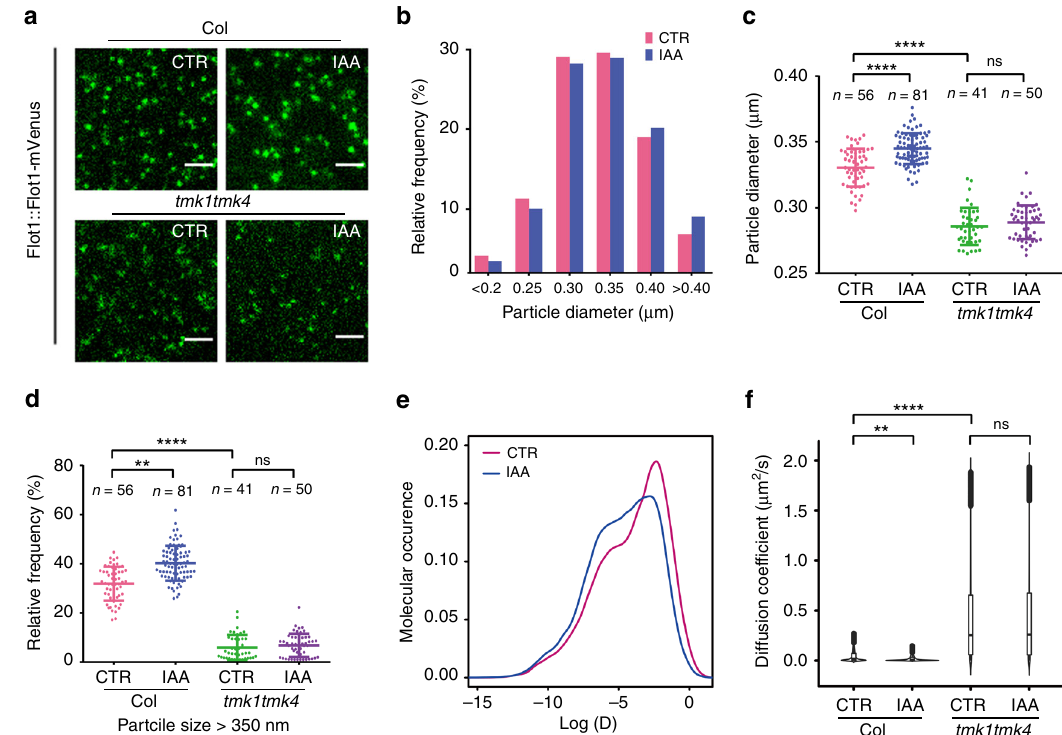
Fig. 4 TMK contributes to the auxin-promoted nanoclustering and stabilization of fl otillin1 particles. a Representative TIRF images of pavement cells expressing fl otillin1:: fl otillin1-mVenus with or without IAA (100 nM, 10 min) treatment in wild type (Col-0) and tmk1tmk4 double-mutant background. Scale bars = 2 µ m. b Histogram of fl otillin1 particle size distribution in control and IAA-treated cells. c Quantitative comparison of fl otillin1 particle diameters in different treatments. d Relative frequency of fl otillin1 particles with size larger than 350 nm. Data are presented as mean ± SD. n represents the number of independent cells. e The density curves of diffusion coef fi cients of fl otillin1 particles in control (pink curve) and IAA-treated (blue curve) cells. f Comparison of diffusion coef fi cients of fl otillin1 particles in different treatments. The number of particles analyzed in each treatment (from left to right) are 49,216, 43,223, 47,078, and 48,206, respectively. CTR, control. Data in b – f are representative of three independent experiments with the same